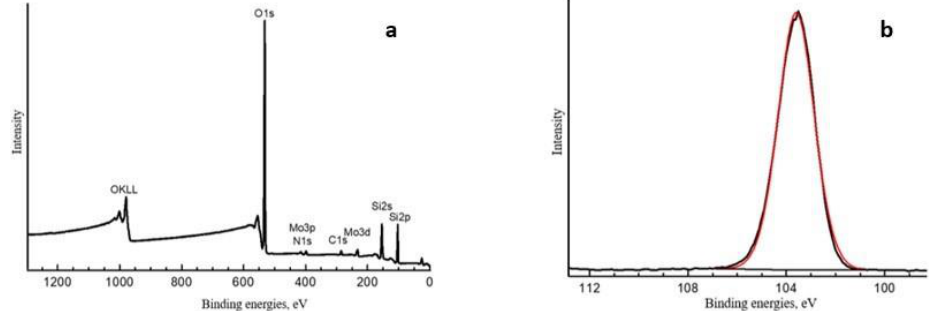
Figure A1. Panoramic ( a ) and Si2p ( b ) XPS spectrum of the test sample.